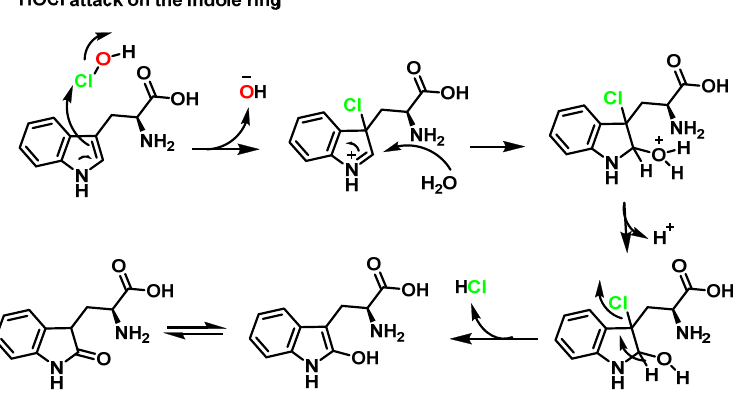
Figure 26. Hypochlorous acid could directly attack the free amino group of the amino acid Trip, with the consequent formation of a chloramine, in an electrophilic substitution mechanism [78] . Lysine and arginine are the second targets of HOCl in proteins, which chlorinates them to form chloramines. Lys and Arg are chlorinated by HOCl or MPO/H 2 O 2 /Cl − at the N of the amino acid chain, as shown in Figure 27.